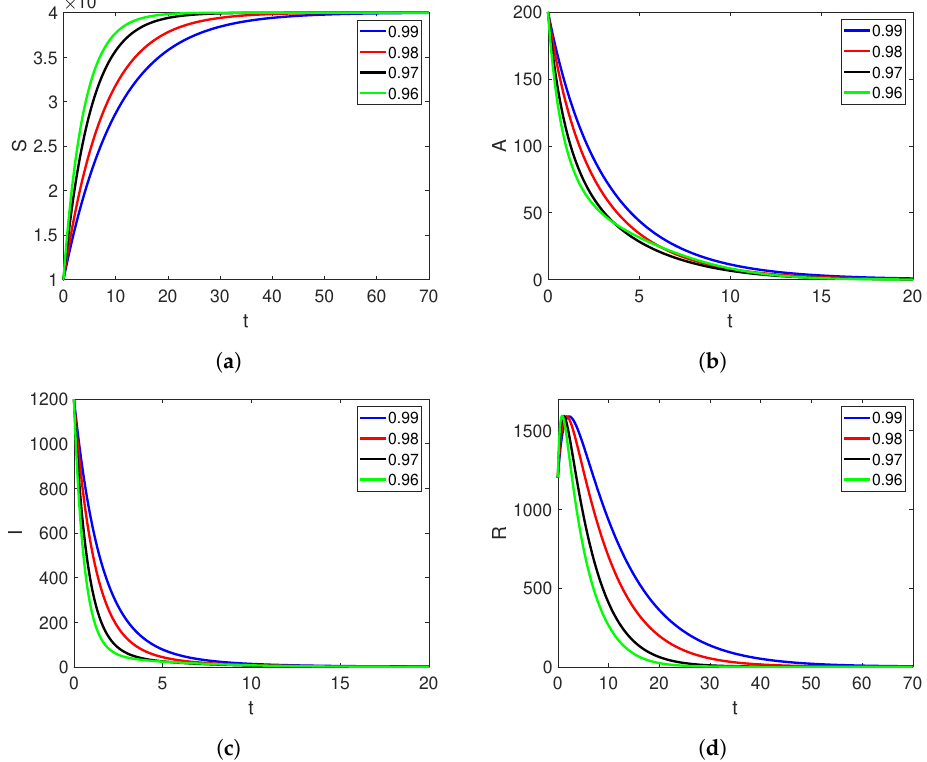
Figure 5. The dynamics of the state variables’ SAIR in model (2) with different fractional orders α vs. time t with initial